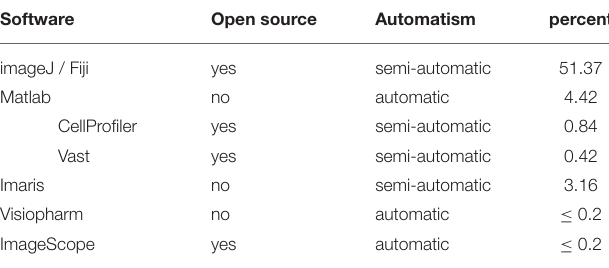
TABLE 7 | Software used to analyze cerebral organoid images.